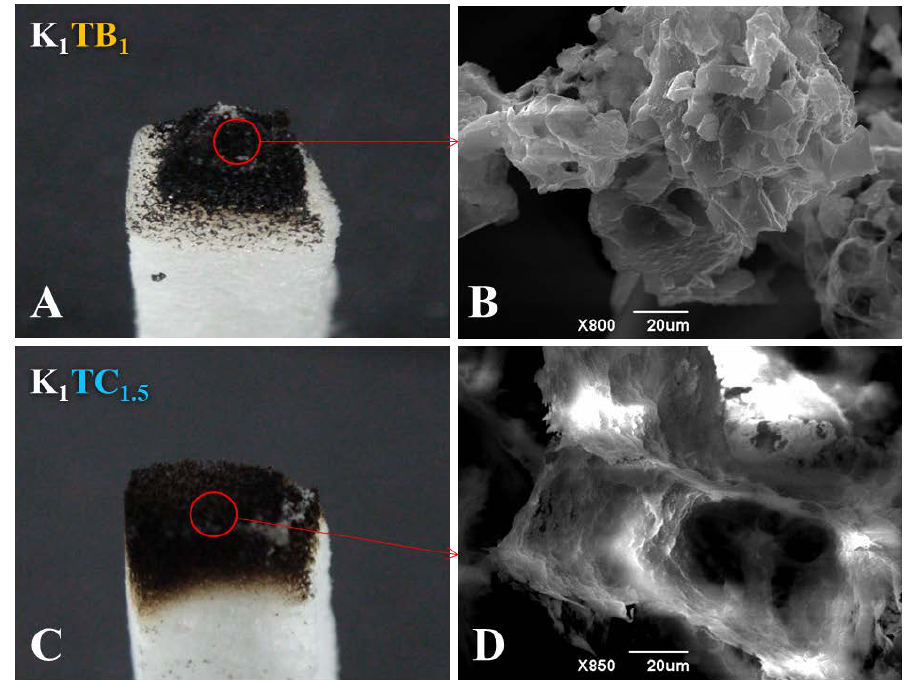
Figure 10. ( A , C ) Macroscopic photograph and ( B , D ) microscopic morphology of ( A , B ) K 1 TB 1 and ( C , D ) K 1 TC 1.5 aerogels after combustion.